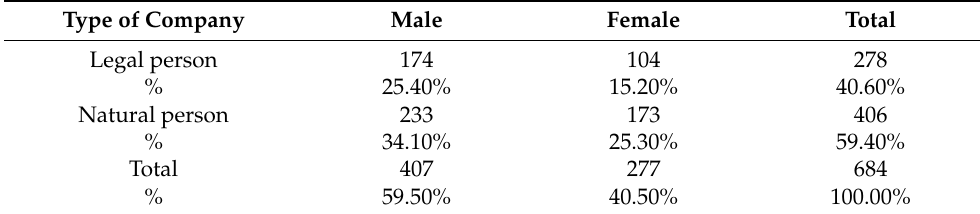
Table 1. Type of company and gender of the manager.